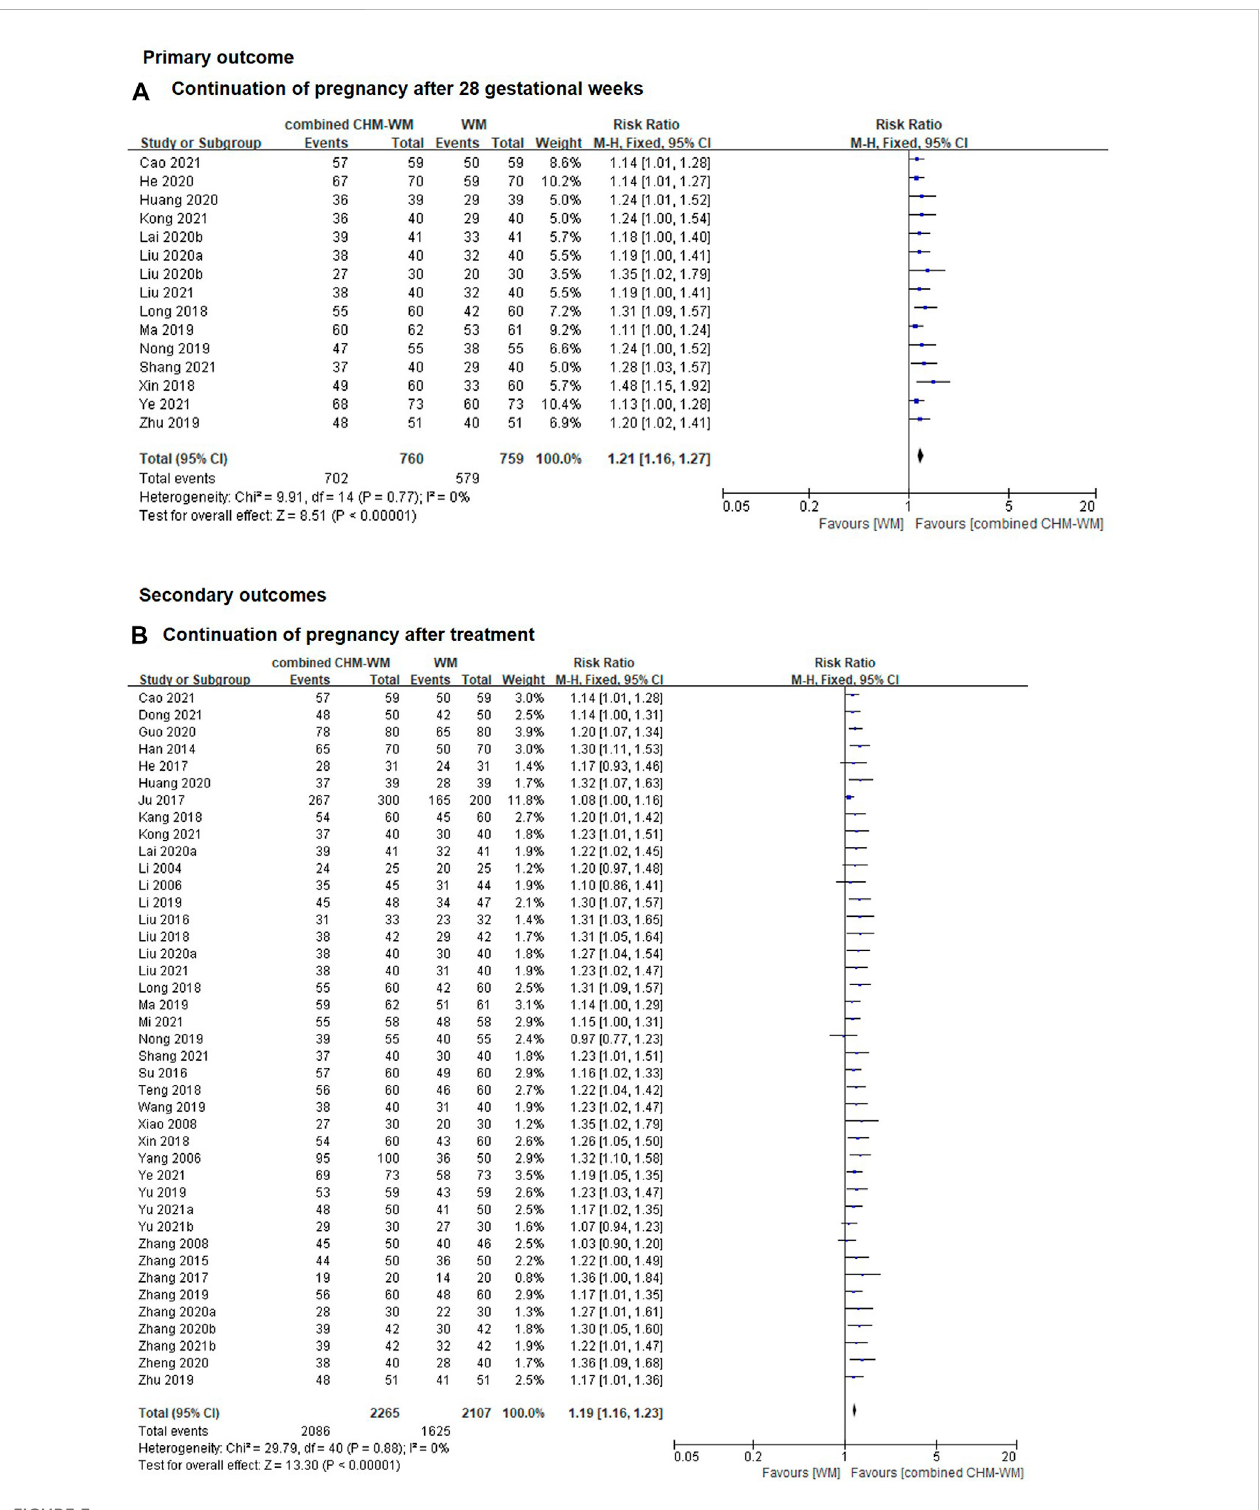
FIGURE 3 Forest plot of combined CHM-WM group versus WM alone group. (A) Continuation of pregnancy after 28 gestational weeks; (B) Continuation of pregnancy after treatment; Preterm birth; (D) Adverse maternal outcomes;Neonatal death; TCM syndrome severity; (G) Subgroup analysis of TCM syndrome severity; β -hCGlevelsaftertreatment;Subgroupanalysisof β -hCGlevelsaftertreatment;Sensitivityanalysisof β -hCGlevelsaftertreatment. (C) pretermbirth; (E) neonatal death; (F) TCM syndrome severity; (H) β -hCG levels after treatment; (I) subgroup analysis of β -hCG levels after treatment; (J) sensitivity analysis of β -hCG levels after